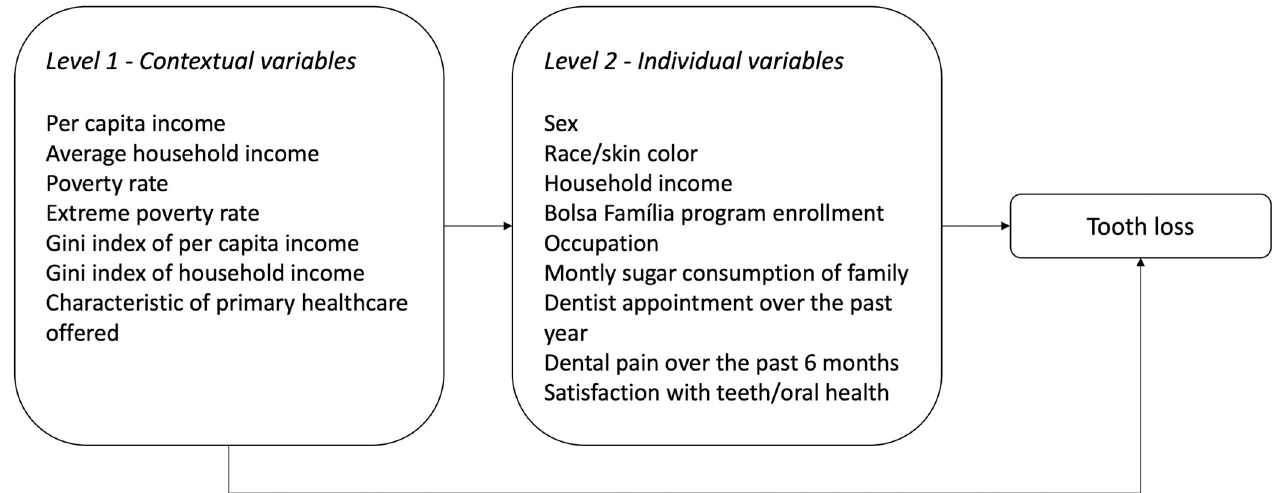
Fig 2. Hypothesized hierarchical analytical model for tooth loss in the rural riverside